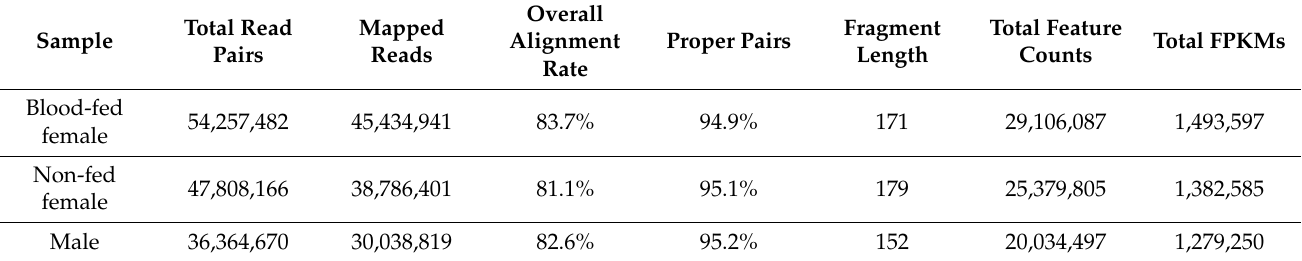
Table 1. RNAseq mapping quality to the An. stephensi SDA-500 genome